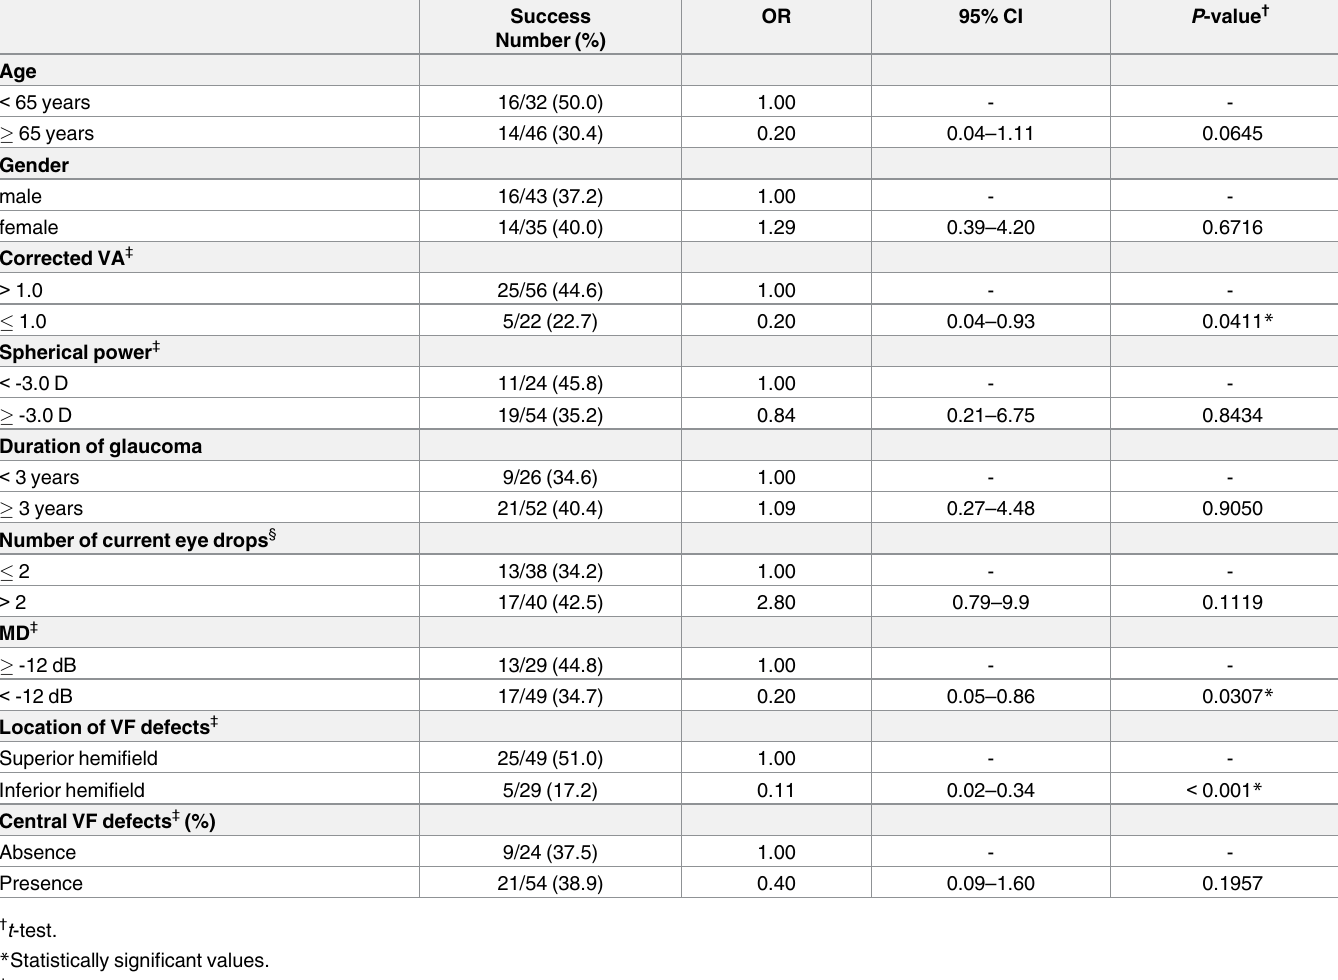
Table 4. Results of multivariate logistic regression analysis for predicting successof drop instillation in glaucoma subjects (n =